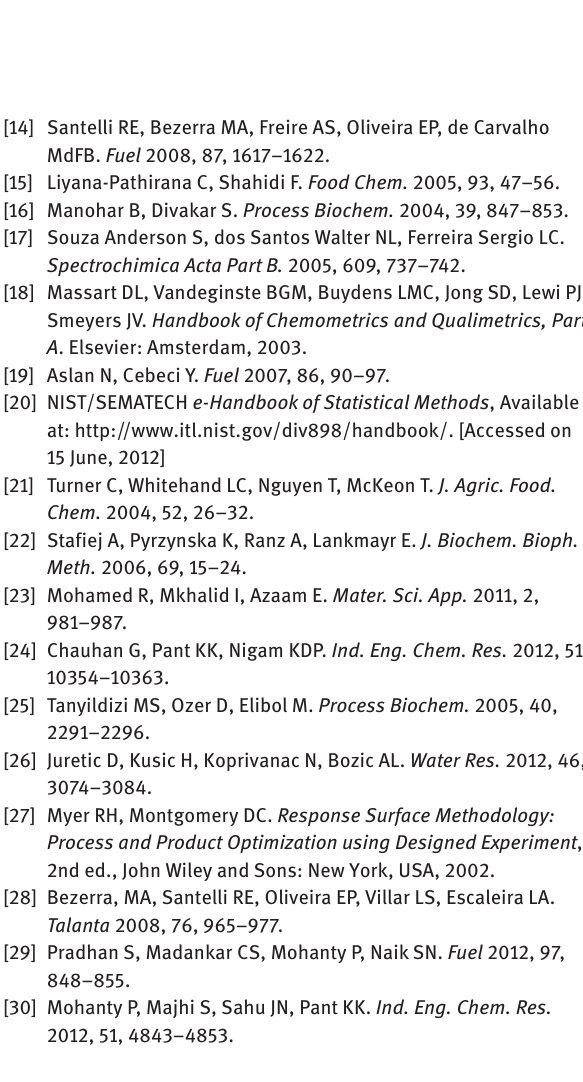
a Standard deviation, b Coefficient of variation, c Predicted residual sum of squares, d Adjusted R-squared, e Predicted R-squared, f Adequate